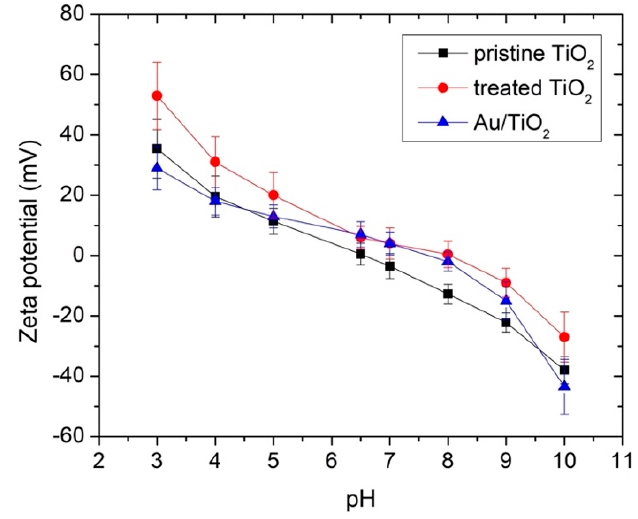
Figure 4. Measured zeta potential values of pristine TiO 2 , plasma-treated TiO 2 , and the Au/TiO 2 nanocomposite at various pH values.